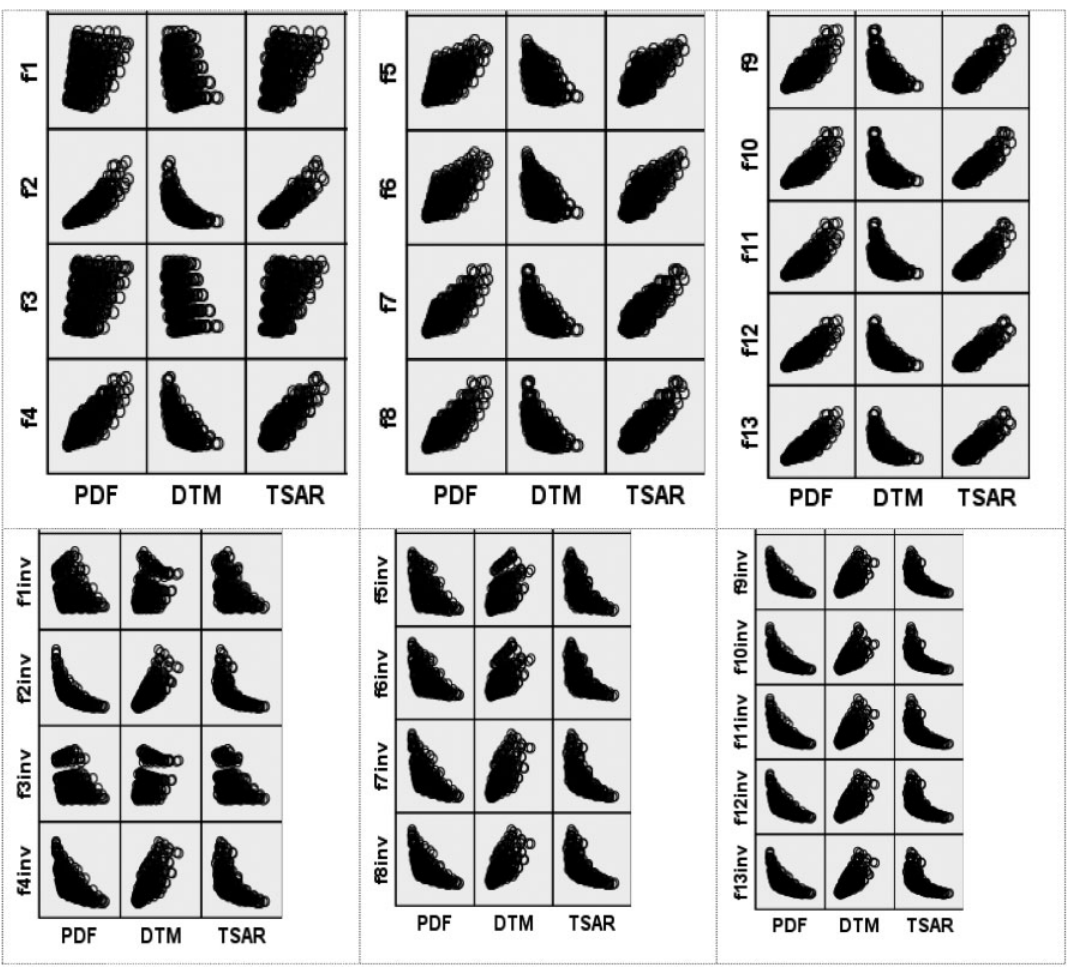
Fig. 9. Matrix scatter plot among three dependent variables ( P DF , D TM , TSAR) and the new nonlinear functions ( f 1 to f 13 and f 1inv to f 13inv